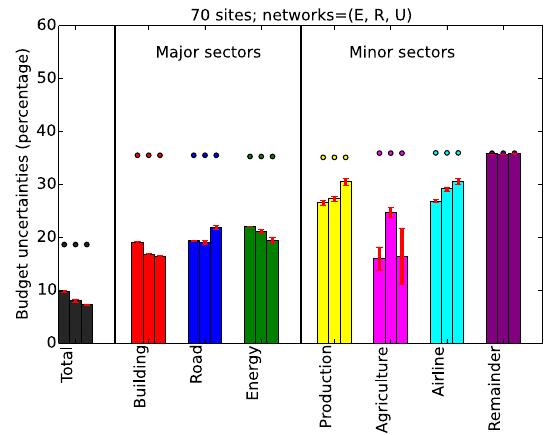
Figure 11. Reduction of uncertainties by inversions using three dif- ferent types of networks of 70 stations with inflated observation er- ror standard derivation (50%